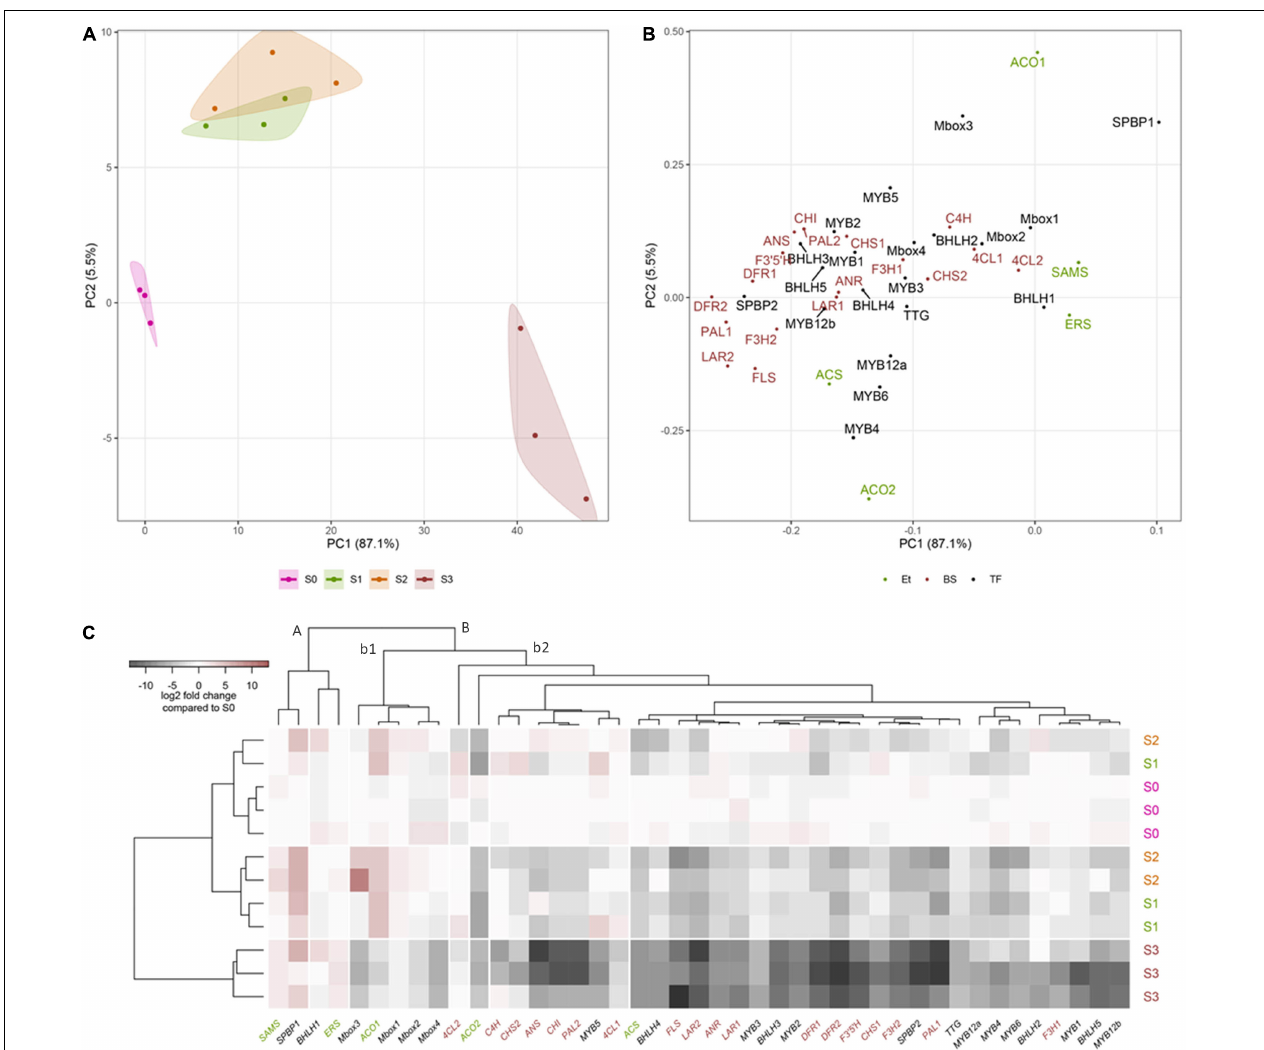
FIGURE 5 | Chemometric analysis of the gene expression data for Cistus flavonoid-related biosynthetic genes (BS, red letters), transcription factors (TF, black letters), and genes involved in ethylene biosynthesis and sensing (Et, green letters). (A) Principal component analysis performed on log2 fold change expression data. The samples are colored by stage (S0–S3) as shown in the legend, and these groups are further encircled by a convex hull of the same color. (B) Principal component analysis variable loadings. (C) Heatmap of log2 fold change expression data. The samples (in rows) are arranged according to hierarchical cluster analysis (Ward’s method of cluster agglomeration) constructed using Euclidean distances (left tree), and the genes (in columns) are arranged according to hierarchical cluster analysis (cluster agglomeration using complete linkage) constructed using Pearson correlation distances (top